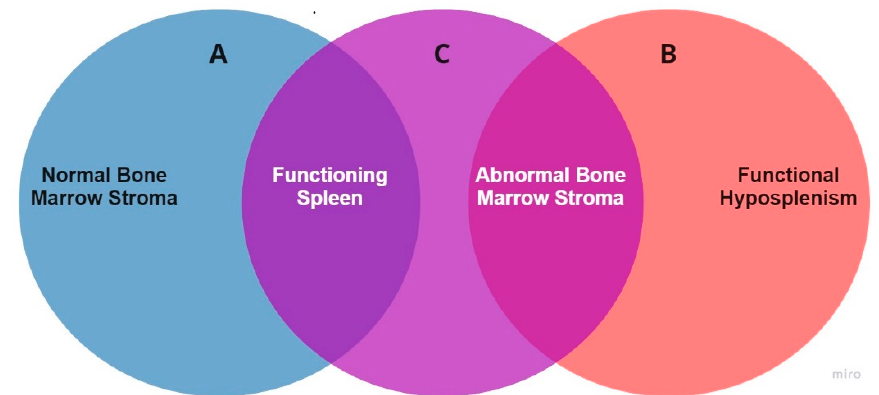
Figure 2. Overlap of biological characteristics between the general population (A), “typical” homozygous sickle cell patients (B) and patients with sickle cell disease at risk of developing fat embolism syndrome (C).